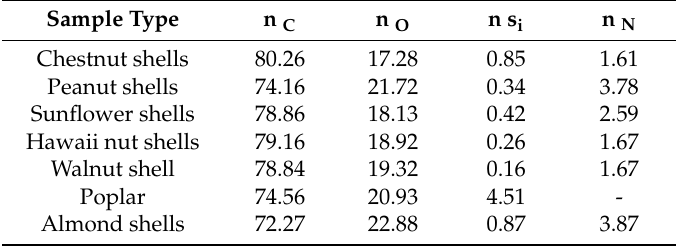
Table 5. Surface chemical composition and relative content of nut and poplar (wt %).